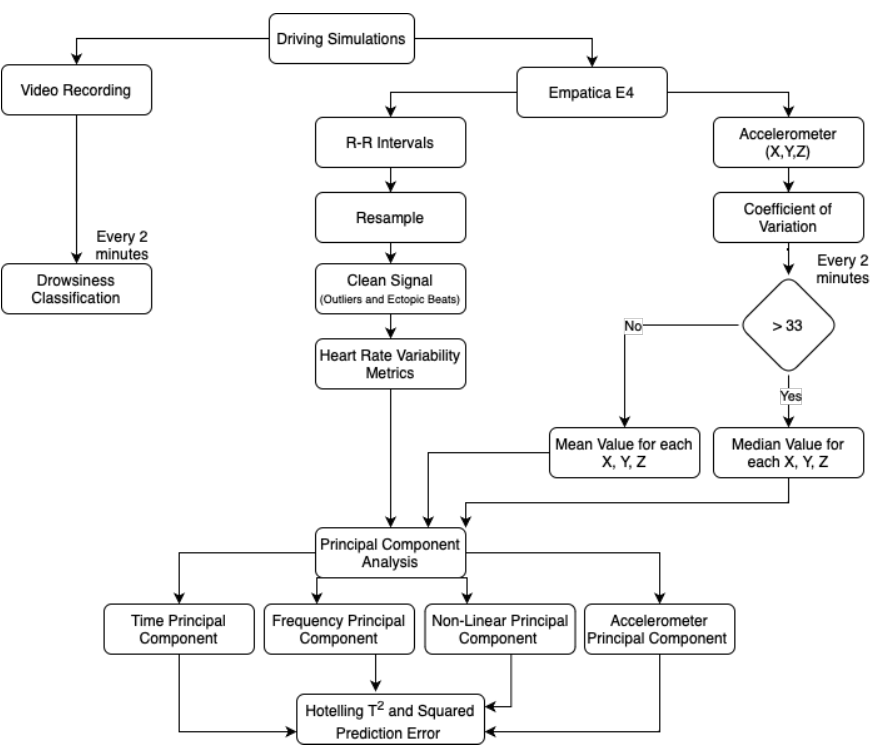
Figure 2. Analysis Procedure